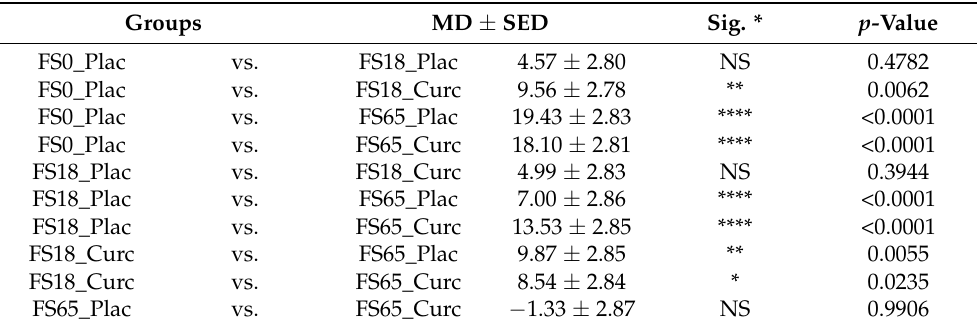
Table 3. Inter-group differences in serum unsaturated iron-binding capacity (UIBC) levels ( µ mol/L) at 180 min.